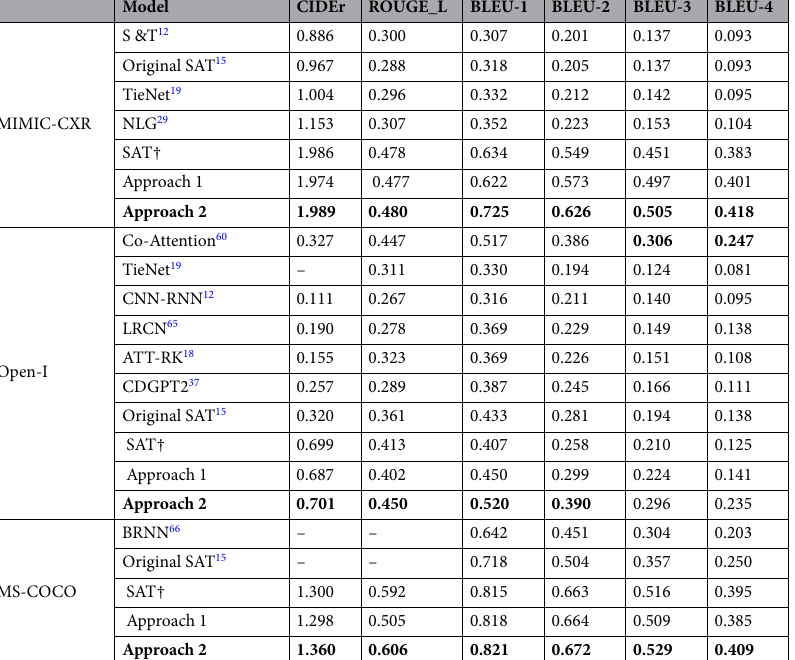
Table 1. Reported mean performance using word-overlap metrics for two medical radiology datasets and one non-medical for general purpose. Models labelled with † stand for the models we implemented and trained with the preprocessed MIMIC-CXR data. Other results are cited from the original papers. BLUE-n denotes the BLEU score that uses up to n-grams. The best performance in each configuration is in bold.